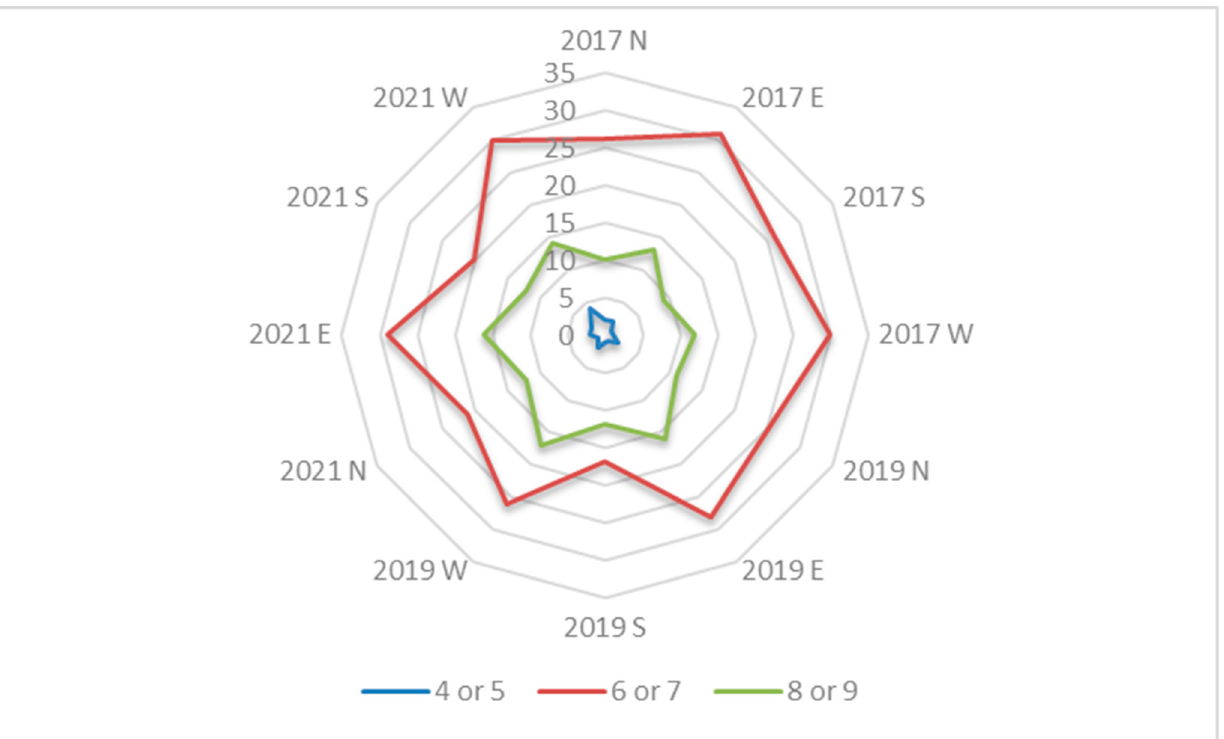
Figure 2. Species assignment according to their light preference using Ellenberg’s indicator values and their distribution in the segments of the vertical green columns in different expositions (north, east, west, and south) in the study years 2017–2022. Ellenberg’s indicator values: 3—shade plants, mostly less than 5% illumination; 4—between 3 and 5; 5—semi-shade plants, rarely in full light, but generally with more than 10% relative illumination; 6—between 5 and 7; 7—plants generally in well-lit places, but also occurring in partial shade, and not found in less than 30% relative illumination; 8—light-loving plants found in relative illumination in summer no less than 40%; and 9—plants in full light, found mostly in full sun, and with illumination in summer no less than 50%.